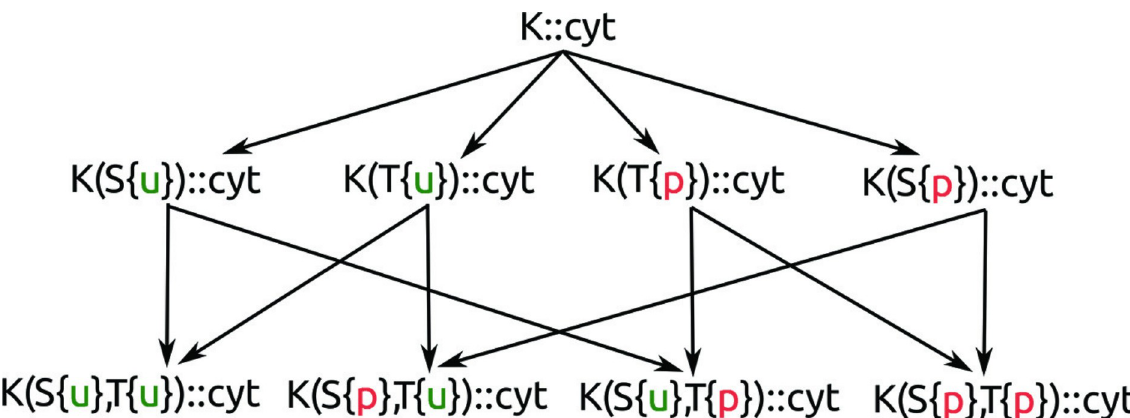
Fig 7. An example of agents partially ordered by compatibility relation. It is formed by a complex in cyt compartment, which has only one structure agent K in its sequence. The structure agent K has atomic agents T and S allowed in its partial composition. They might occur in two states— u and p . All relevant agents are interconnected by compatibility